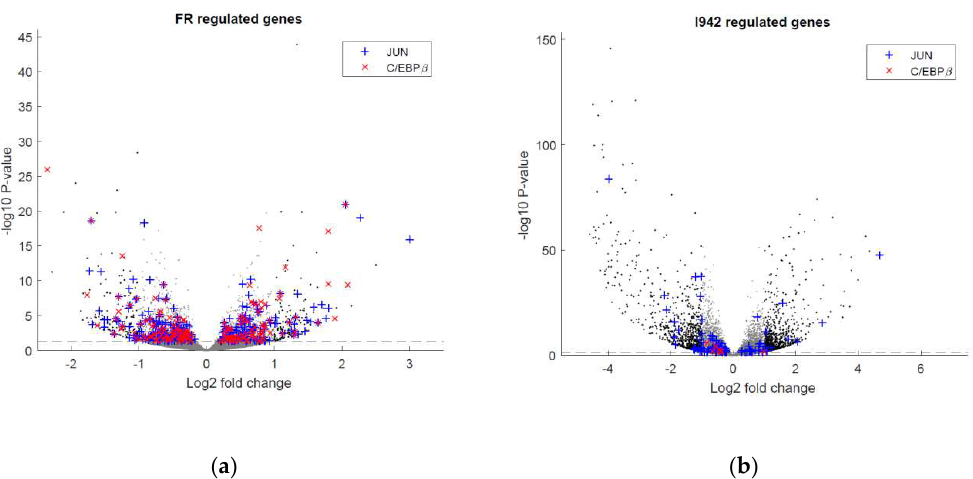
Figure 4. The RNAseq data generated for Figure 1 was re-analysed to identify gene expression changes associated with c-Jun (blue) or C/EBPβ (red) recruitment associated with either ( a ) F/R or ( b ) I942 treatment from ChIP-SEQ experiments.